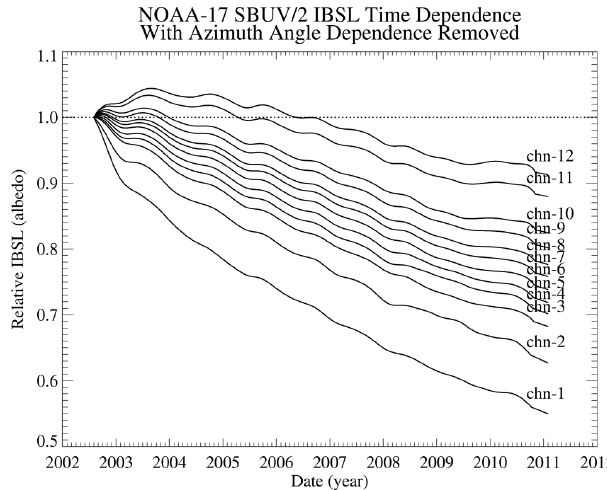
Fig. 18. NOAA-17 SBUV/2 uncorrected radiance data for July 2002 at 273.6nm and solar zenith angle > 60 ◦ for Northern Hemi- sphere measurements (blue) and Southern Hemisphere measure- ments (red). The onset of the in-band stray light (IBSL) error is evident at SZA = 76 ◦ –78 ◦ in the Southern Hemisphere. The satel- lite passes into the Earth’s shadow at SZA = 117 ◦ while orbiting at an altitude of 810km.